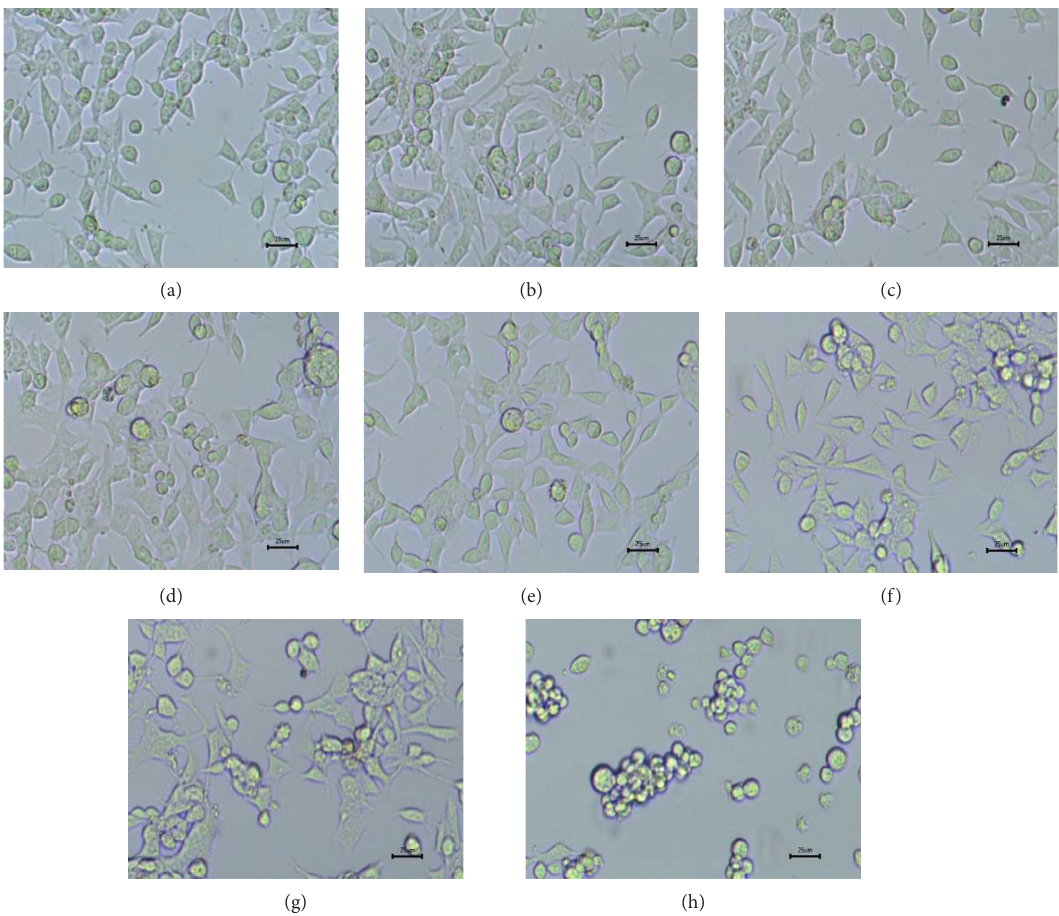
Figure 3: Concentration-dependent cytotoxic effects of lentinan on HUVECs. Figures A-H are HUVECs treated with lentinan at con- centrations of 0, 0.04, 0.4, 0.8, 1.2, 2, 4, and 10 μ M, respectively. Scale bar � 25 μ m.